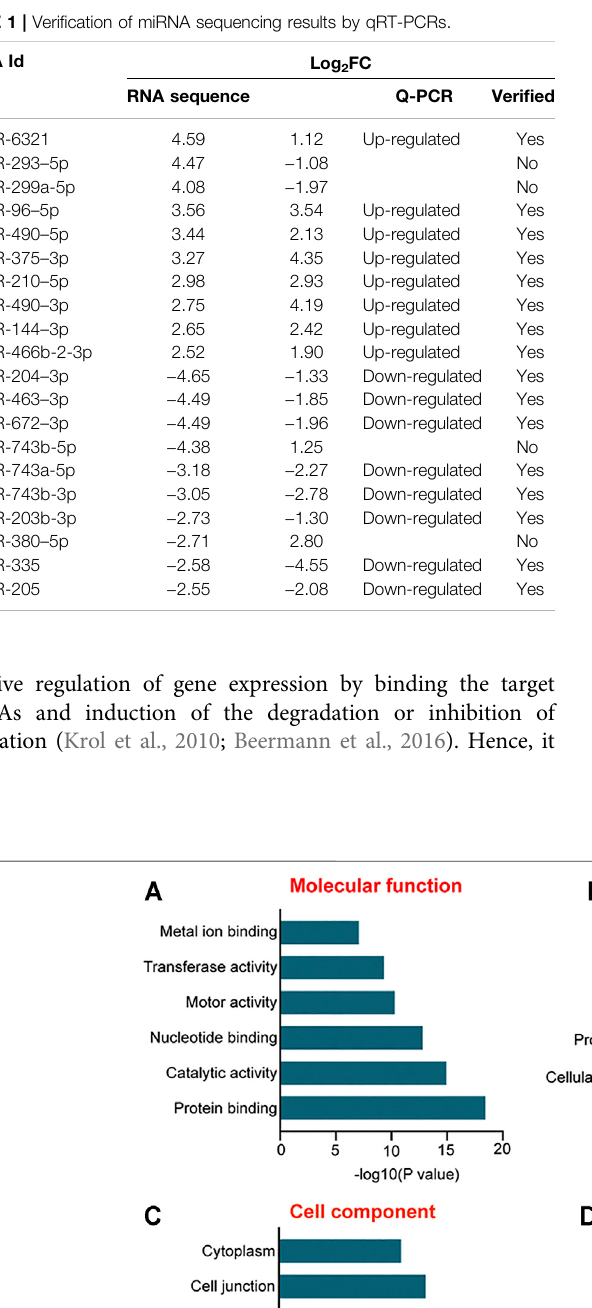
TABLE 1 | Veri fi cation of miRNA sequencing results by qRT-PCRs.